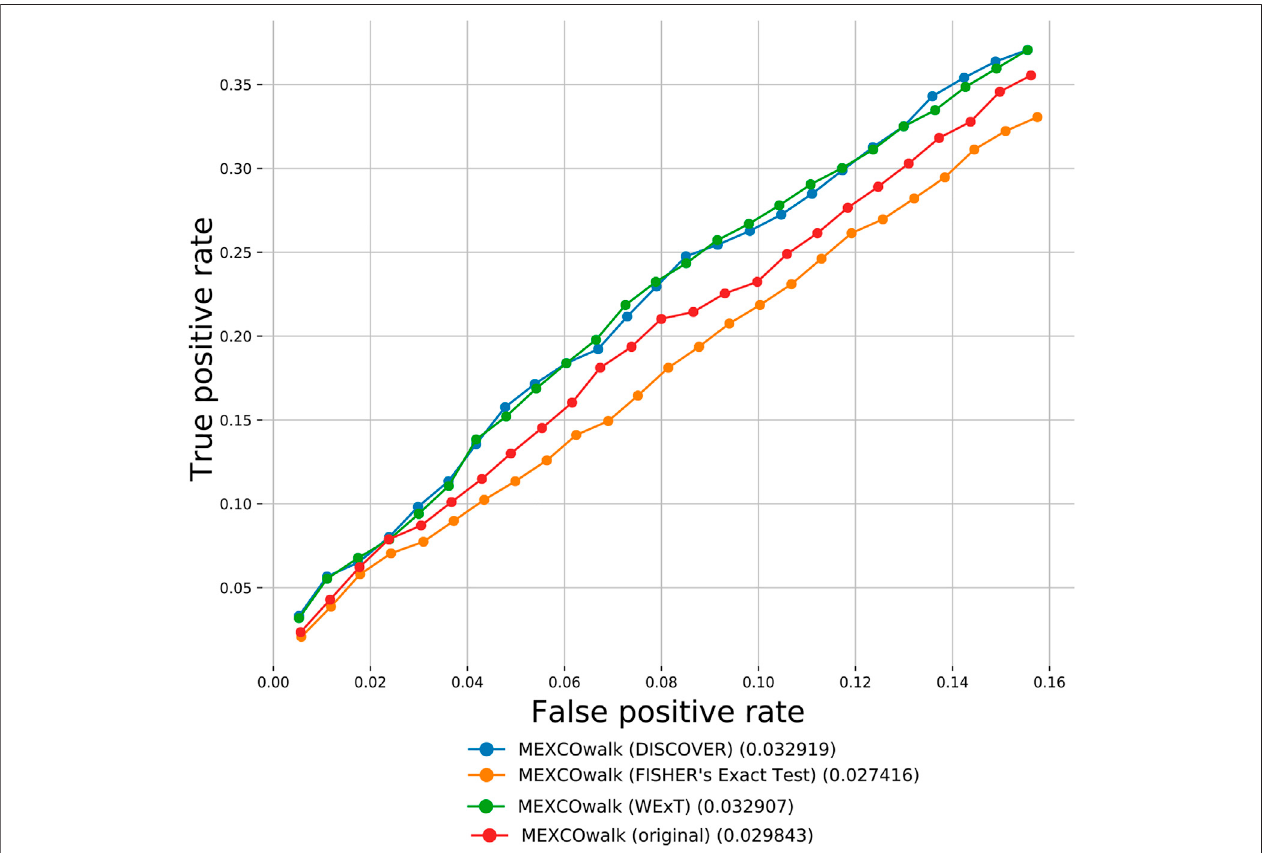
FIGURE4| ThenumberofrecoveredCGCgenesfortheoriginalMEXCOwalkaswellasforitsmodi fi edversionswheremutualexclusivityvaluesareestimatedwith DISCOVER, Fisher ’ s Exact Test and WeXT. COADREAD dataset is used with t (cid:2) 5 setting. The numbers in parentheses indicate the area under the ROC curve for the corresponding